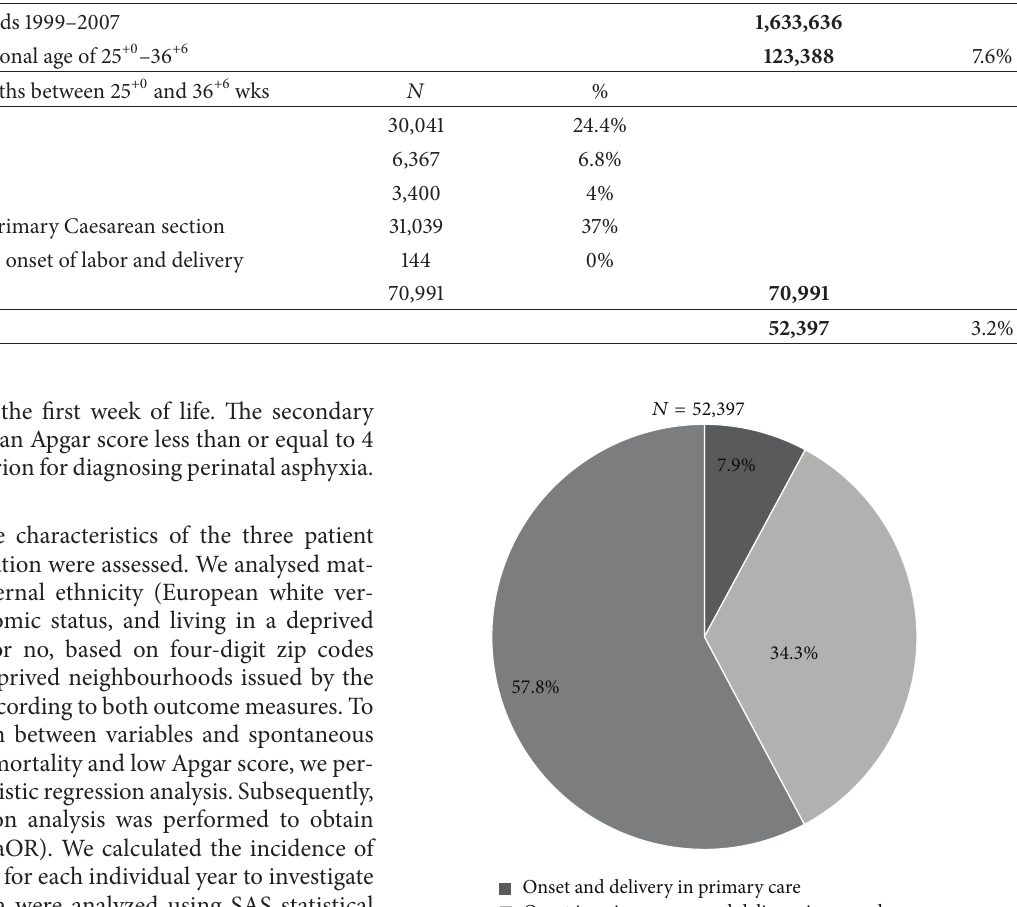
Table 1: Study population.